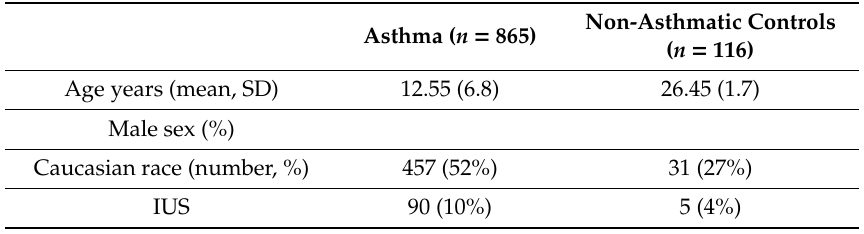
Table 5. Characteristics of the Asthma BRIDGE subjects used to test for the association of miR-15a with asthma susceptibility and disease severity.